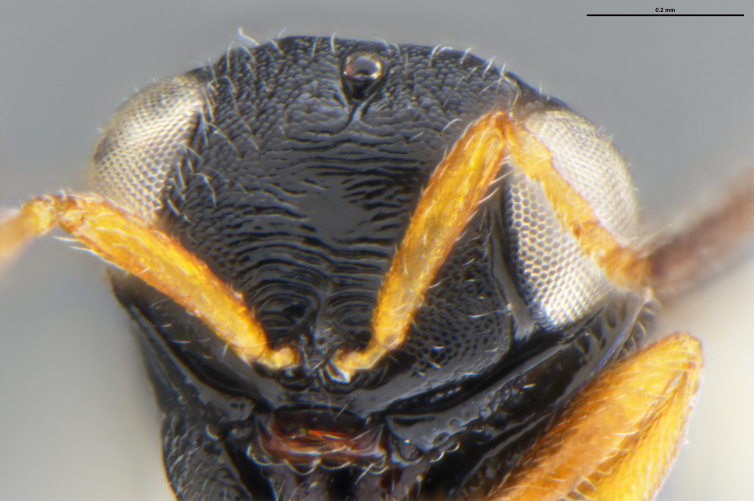
head, anterior view